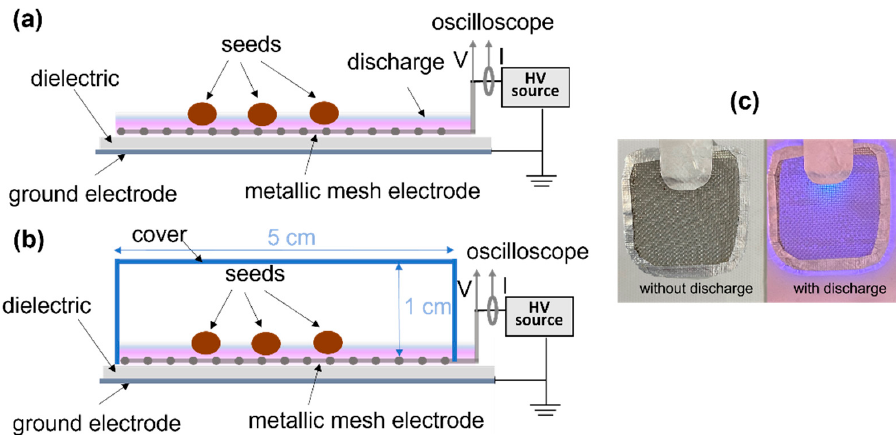
Figure 1. Schematic representation of the flexible configuration used for the seed treatments: ( a ) direct plasma, ( b ) with cover, ( c ) picture of the electrode from above without and with discharge. To ignite the discharge, a high-voltage (HV) signal source was used, HV18K603AC, which produced a 10 kHz signal of up to 18 kV peak-to-peak value. The discharge was produced on top of the mesh electrode in open air, without the use of any other gas. For